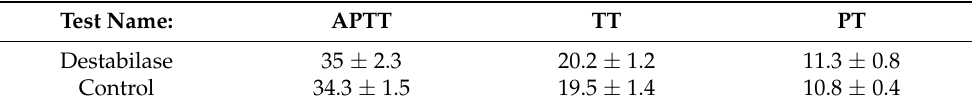
Table 2. Coagulation tests